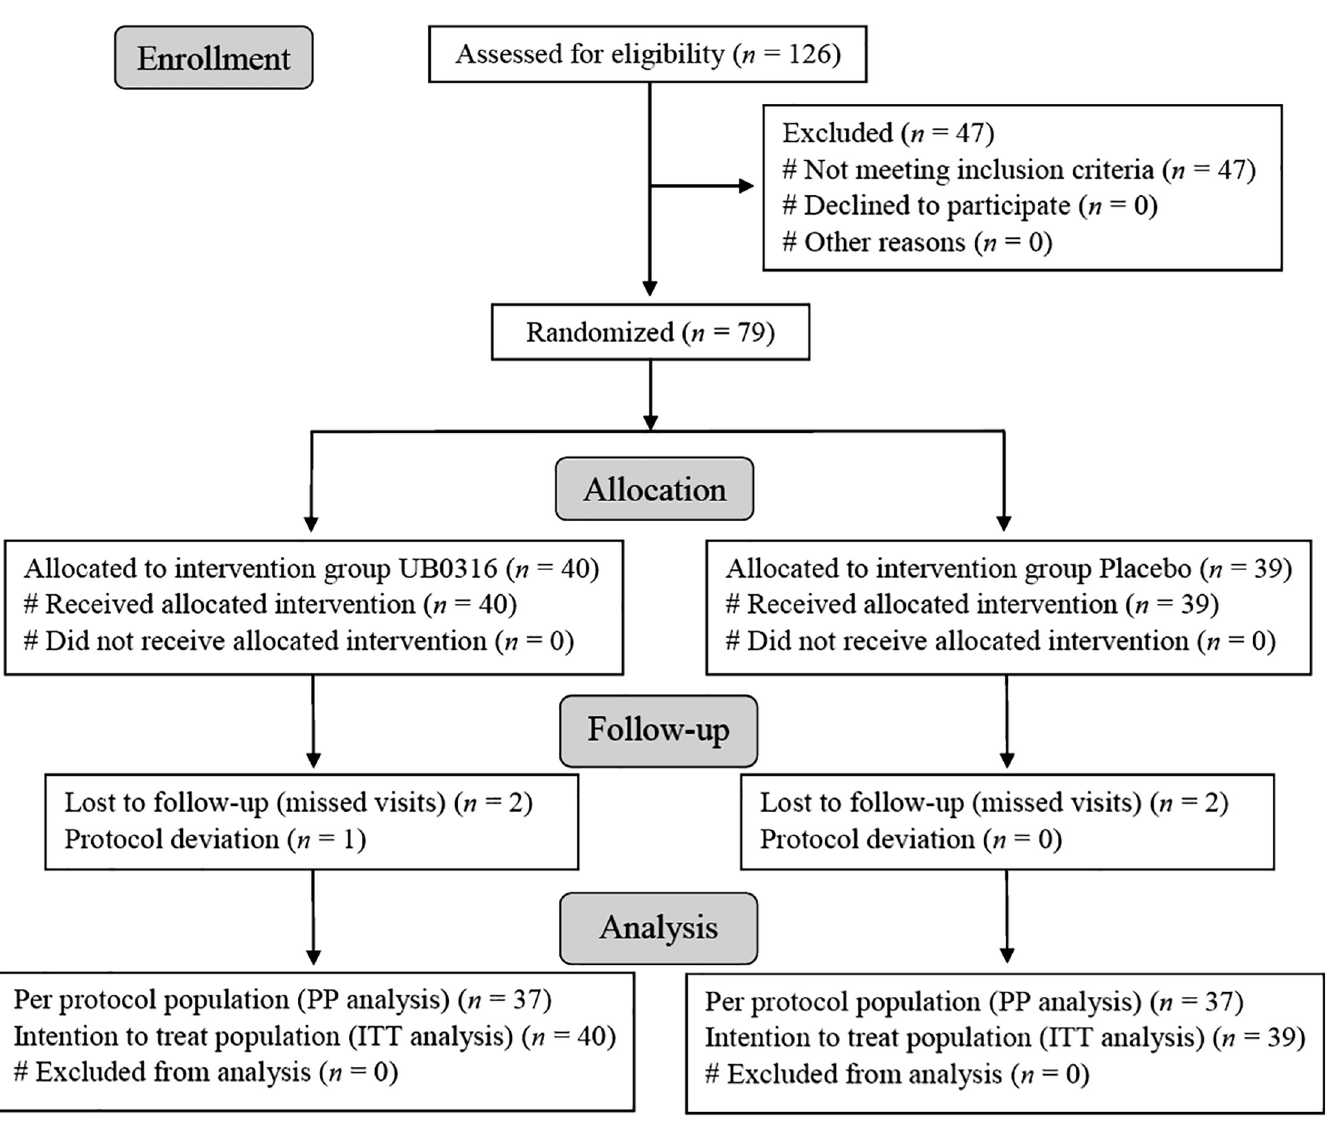
Fig 1. Participant flowchart of the trial. baseline (147.60 ± 48.40 mg/dL). (Table 2, Fig 2). Similarly, in the placebo group there was an insignificant reduction ( p = 7855) in fasting sugar levels (147.80 ± 51.83 mg/dL) as compared to the baseline (150.70 ± 41.30 mg/dL), (Table 2, Fig 2). Moreover, the fasting blood glucose reduction with UB0316 treatment was insignificant ( p = 0.0709), as compared to placebo. The analysis performed on PP population showed that UB0316 treatment significantly ( p = 0.0169) reduce fasting blood glucose as compared with placebo (Table 2). Homeostatic Model Assessment of Insulin Resistance (HOMA-IR) and Insulin. In ITT population, the HOMA-IR (2.50 ± 1.24 units) and insulin (7.70 ± 3.76 μ lU/mL) levels were insignificantly ( p = 0.1412; 0.3126) reduced from their baseline (3.00 ± 2.04 units; 8.70 ± 5.26 μ lU/mL), when participants were treated with UB0316 for 12 week (Table 2, Fig 2). Simi- larly, placebo supplementation did not cause significant ( p = 0.6702; 0.8625) change in either insulin (9.00 ± 4.14 μ lU/mL) or HOMA IR (3.10 ± 1.38 units) levels as compared to the